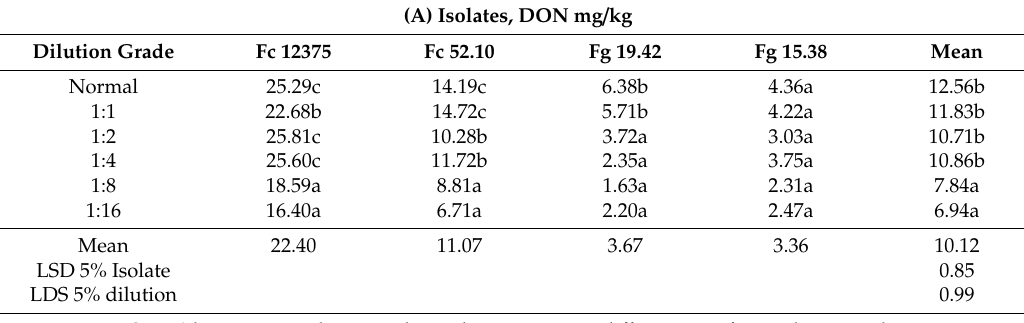
Table 7. Reduction of the aggressiveness of F. graminearum and F. culmorum isolates at di ff erent dilutions across experiments and genotypes, measured by DON contamination mg / kg in 2013–2014. ( A ) Isolates, DON mg / kg. ( B ) Correlations between responses of isolates to dilution